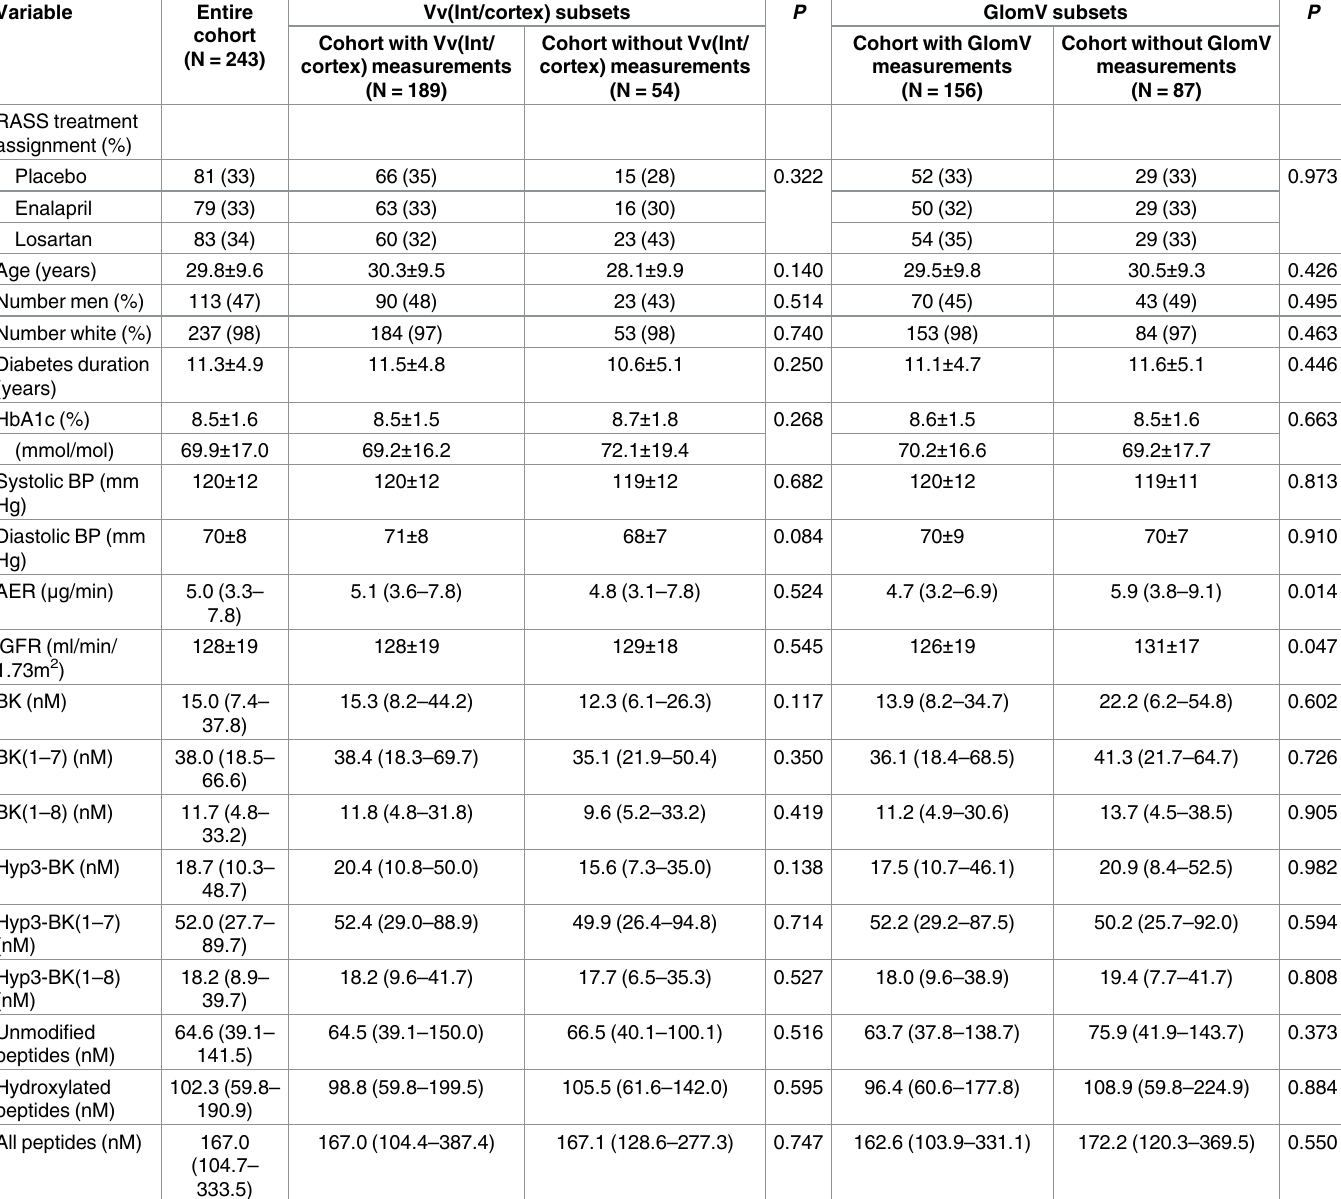
Table 1. Clinical characteristics at baseline of the 243 participants in RASS with type 1 diabetes who had two kidney biopsies and measurements of plasma bradykinin and related peptides, and the subsets with cortical interstitial fractional volume and glomerular volume